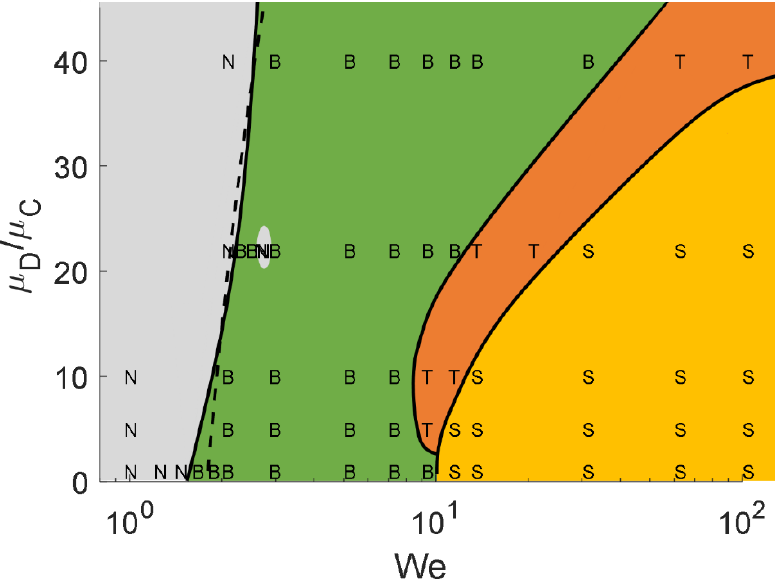
Figure 13. Parameter map, showing the initial breakup morphology (S: Sheet, T: Thread, B: bulb; N: none) as a function of Weber number, We , and viscosity ratio, μ D /μ C . Solid lines and colored fields are free-hand attempts to illustrate demarcations between morphologies. Dashed line shows the effect of the viscosity ratio on critical Weber number according to the viscosity-corrected Kolmogorov – Hinze theory [8] (rescaled with a proportionality constant complying with the numerical simulations; see text).